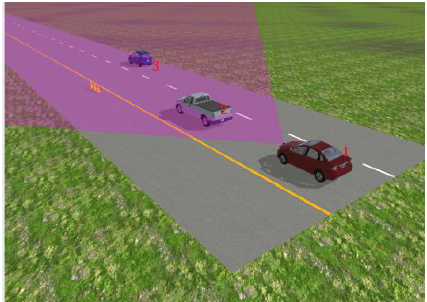
Figure 25. Test scenario for autonomous emergency braking (AEB) decision algorithm.